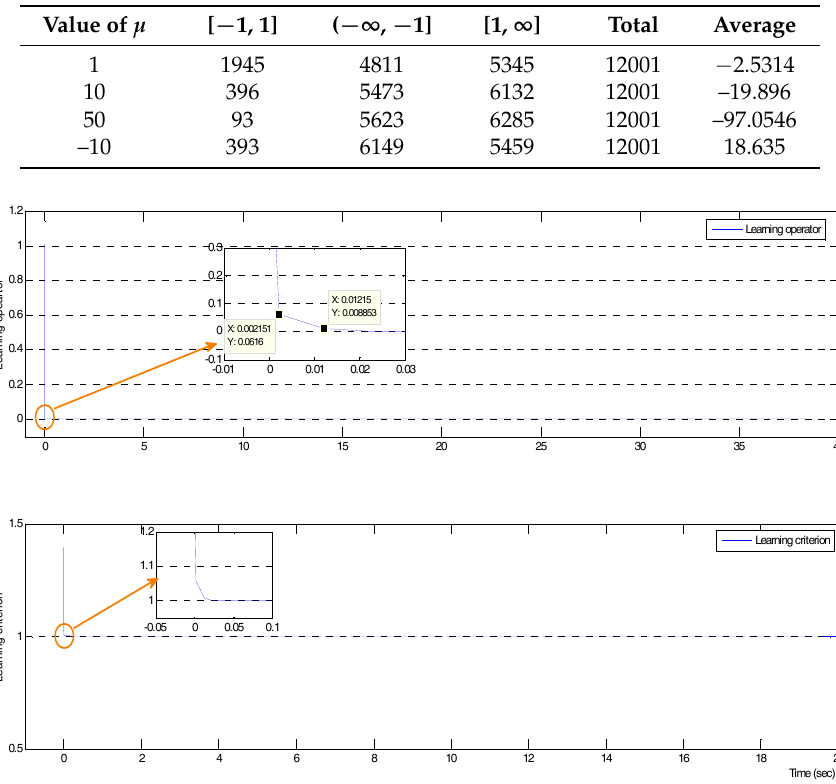
Figure 7. The behavior of the Iterative Learning Control operator and criterion.